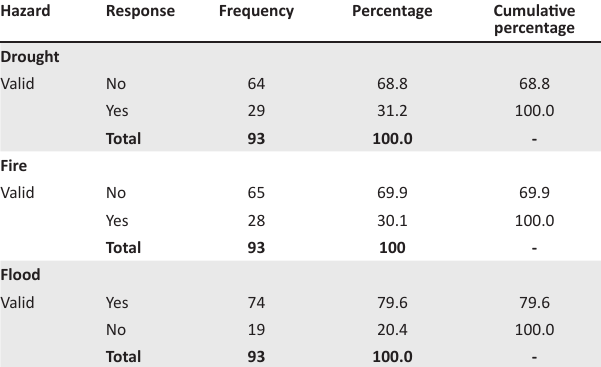
TABLE 7: The capability of wetlands to reduce the impacts of flood, drought and fire in communal wetlands. Hazard